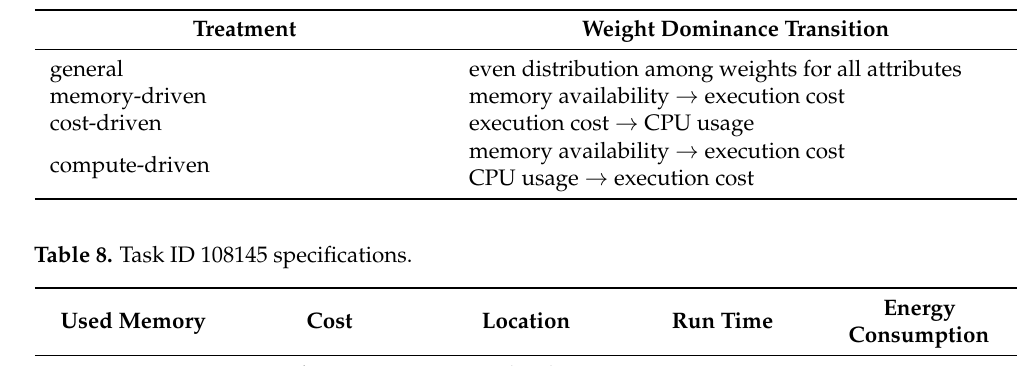
Table 7. Weight assignment outline for test cases explored in Sections 3.1–3.4.